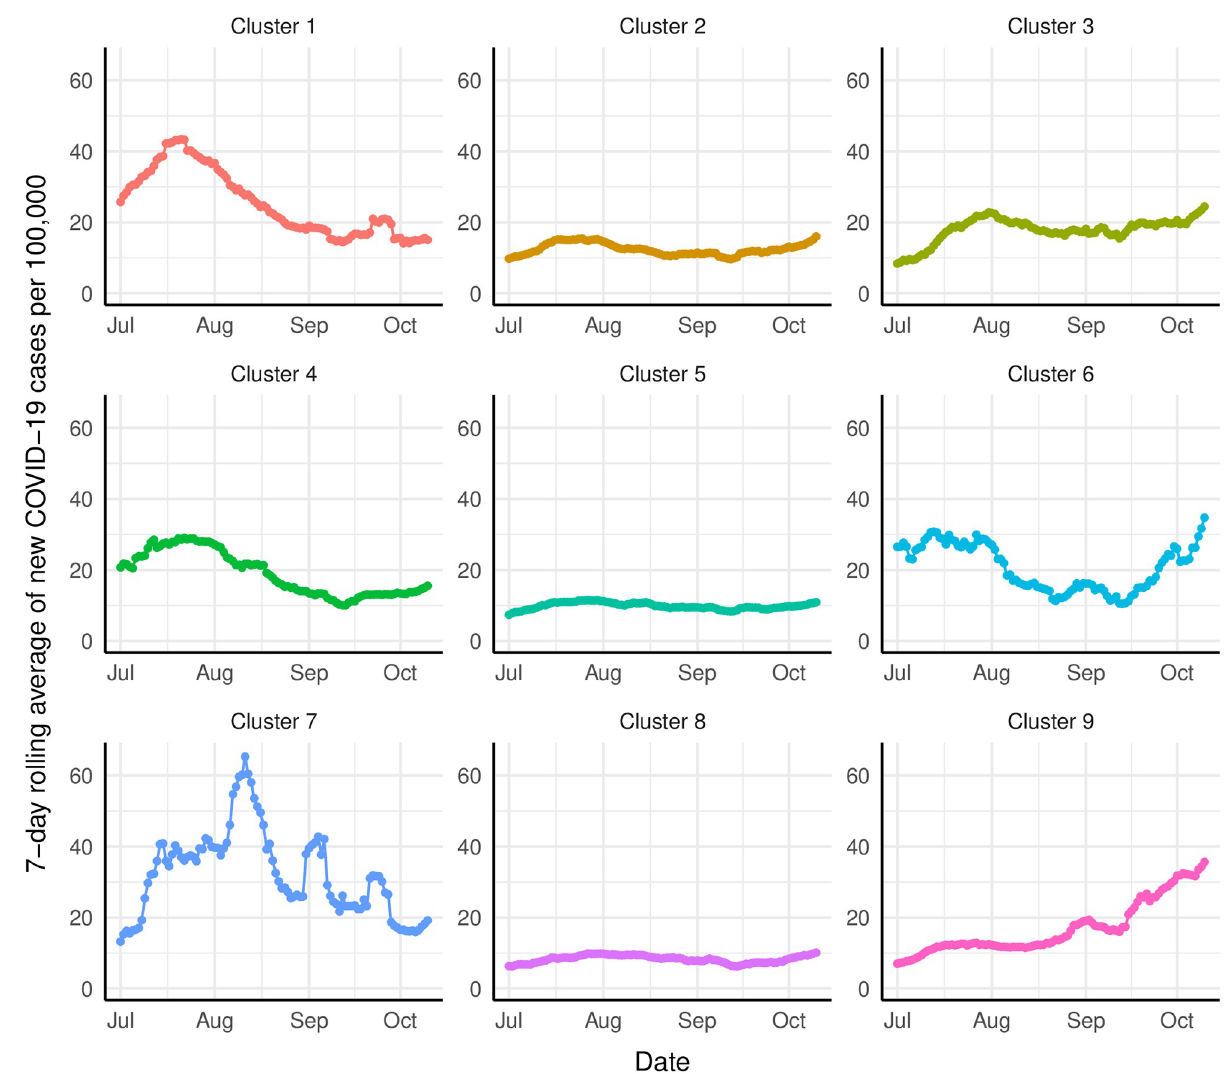
Fig 6. Cluster per capita COVID-19 case